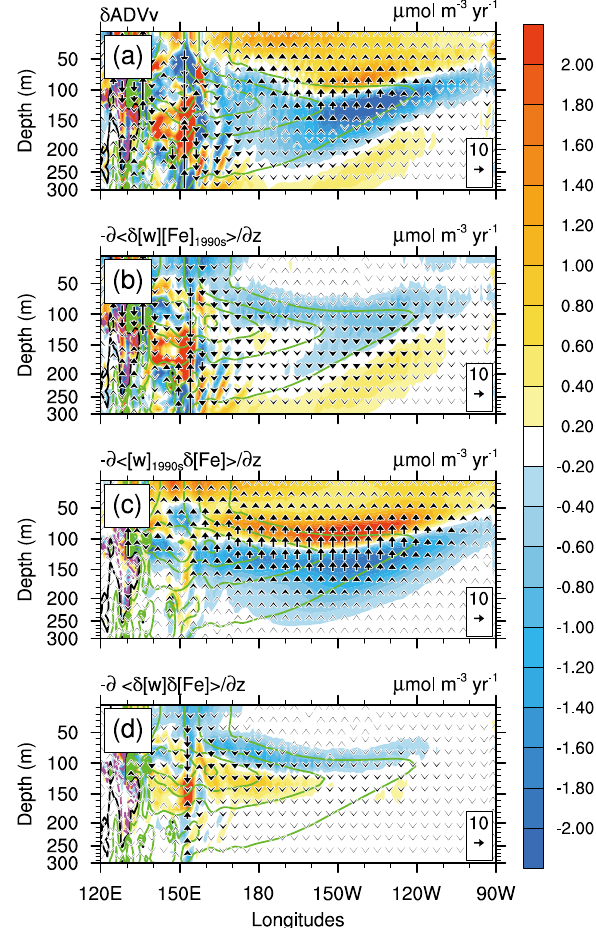
Fig. 13. The same as Fig. 8h (a) . Decomposition of δ ADVv using Eq. (8) (b–d)